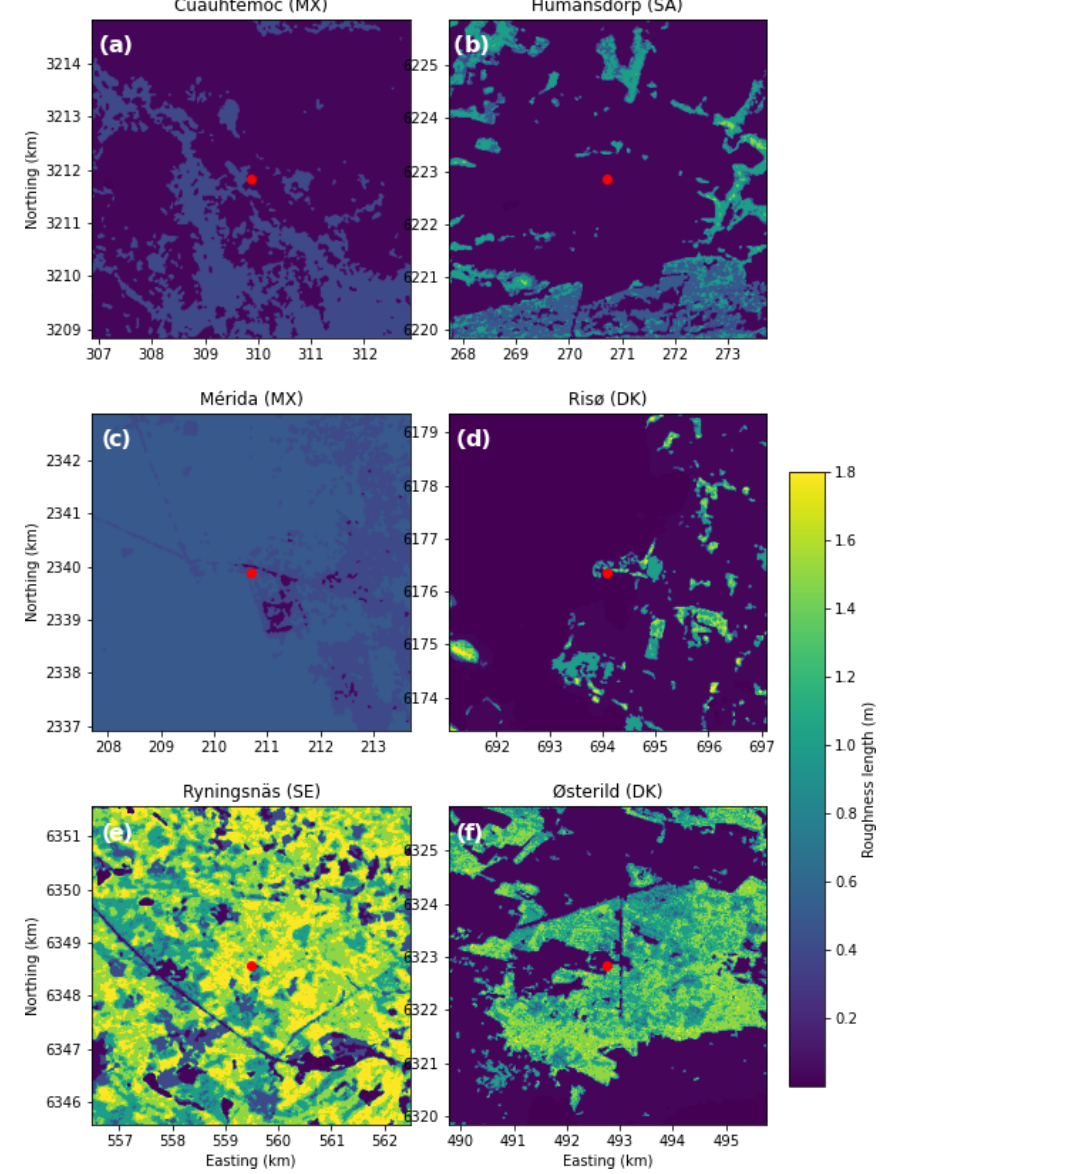
Figure 5. Roughness lengths obtained from a 6 × 6km square around the meteorological mast (red point) from Cuauhtémoc (a) , Humans- dorp (b) , Mérida (c) , Risø (d) , Ryningsnäs (e) , and mast 1 at Østerild (f) from the Sentinel ORA 20